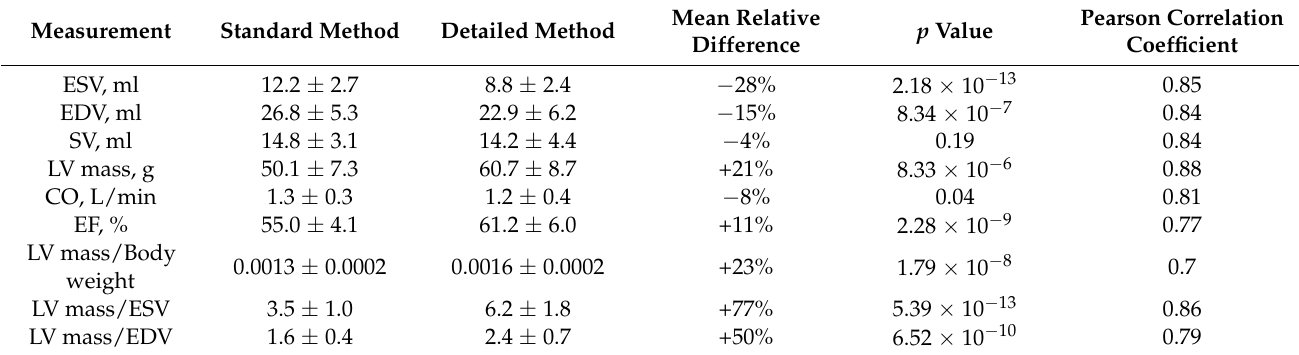
Table 1. Volumetric analysis comparison of the normal hearts of the Yucatan minipigs using the standard method and the detailed method ( n =